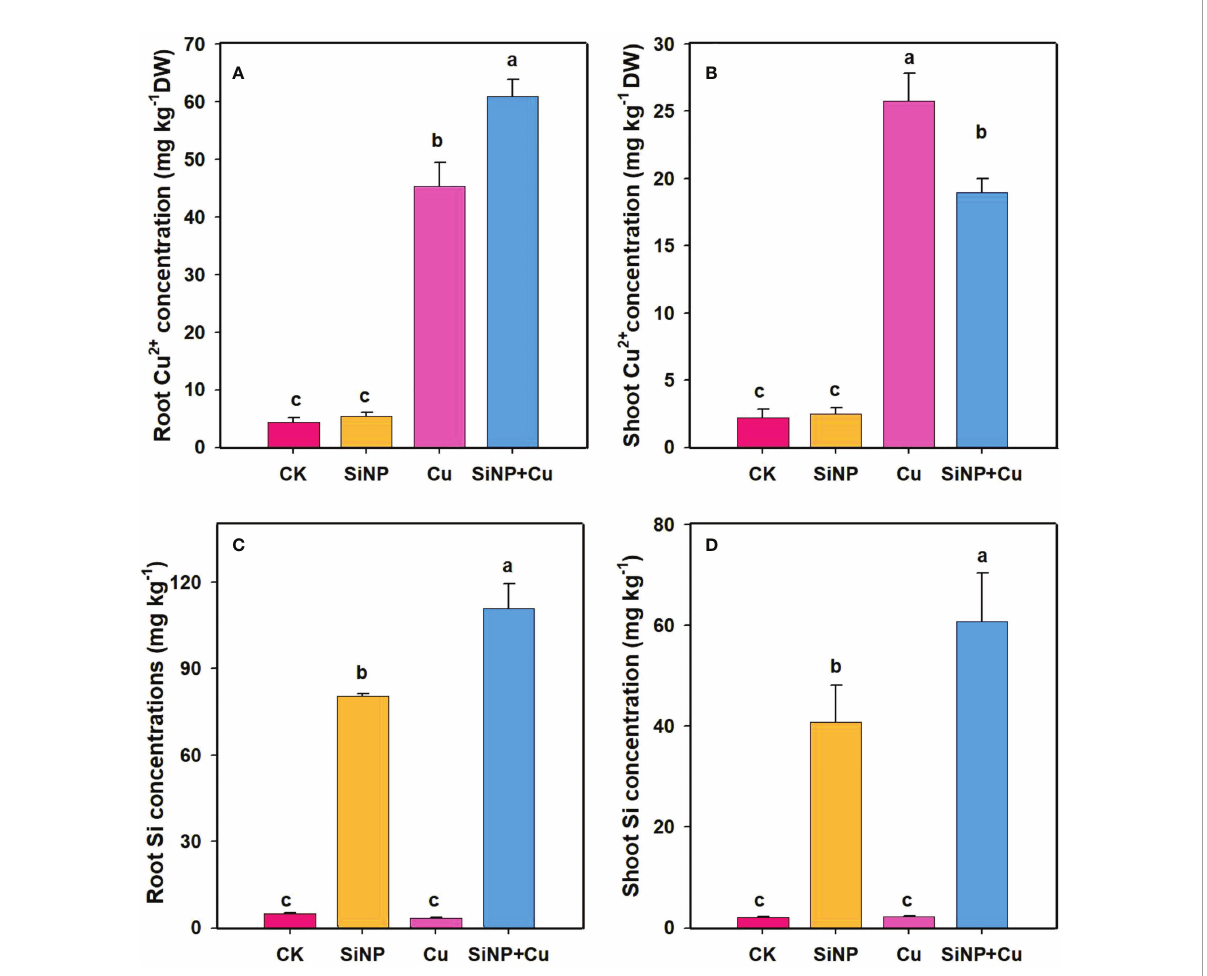
FIGURE 8 Cu 2+ and Si contents of wheat seedlings under Cu 2+ stress. Note “ Experimental treatments contained: CK (control); SiNP (2.5 mM SiNPs); Cu (500 µM Cu 2+ alone), SiNP+Cu (2.5 mM SiNPs+500 µM Cu 2+ ). The different letters (a, b, c, d) describe the differences in different treatments by LSD test at (P ≤ 0.05) ” . (A) root Cu2+, (B) shoot Cu2+, (C) Root Si, (D) shoot